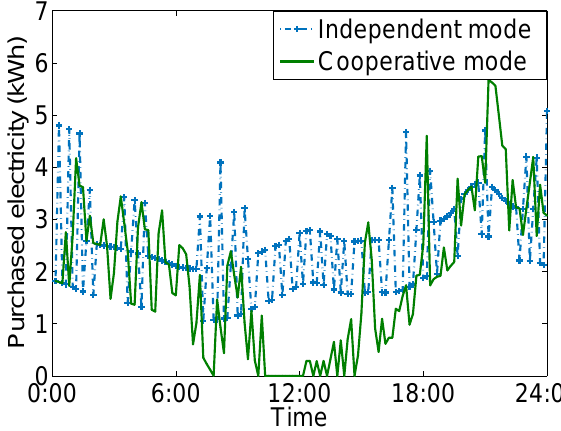
Figure 4. Comparison of purchased electricity from the main